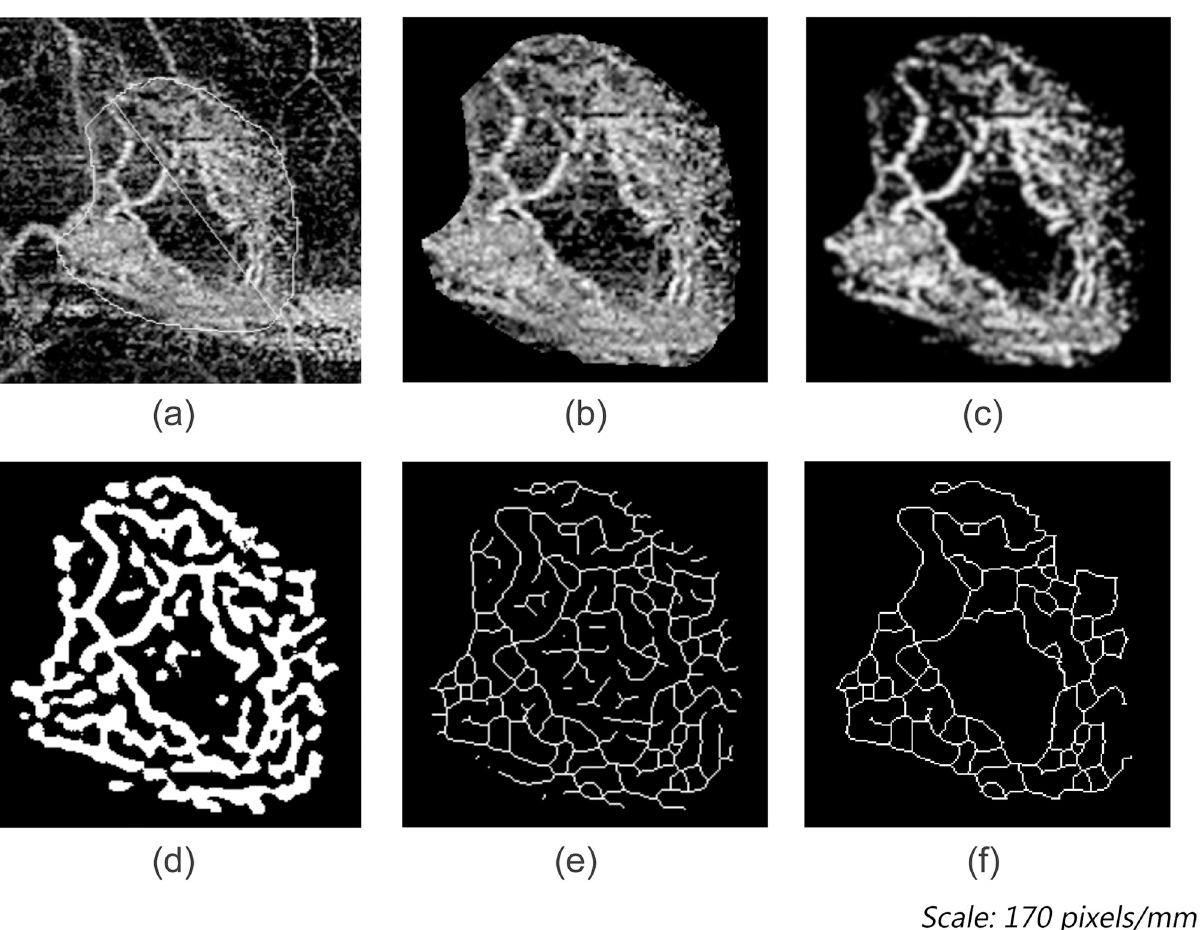
Fig 3. Intermediate stages of the OCTA image as it travels down the pipeline. (a) Input OCTA image showing the active mCNV lesion. (b) Manually delineated OCTA image. mCNV area is measured by counting the pixels within the contour. (c) The Gaussian kernel and Contrast adjustment were used for smoothing and denoising. (d) The Frangi vesselness filter and Mexican Hat filter were used to calculate Vessel Area and Vessel Density. (e) Binary skeletonization of the OCTA image using ImageJ. (f) The tagged skeleton was used to calculate the Junctions, Vessel Diameter, Tortuosity, and Fractal